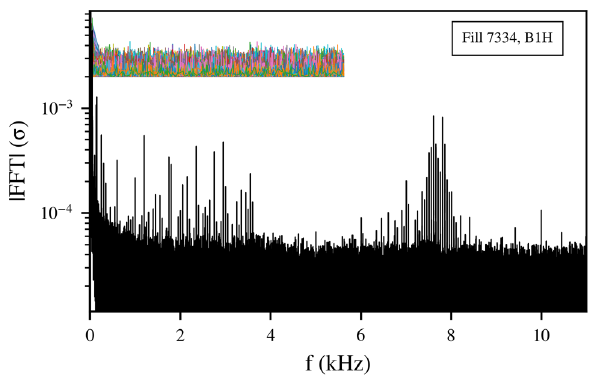
FIG. 20. The spectral envelope of several individual bunches (colored lines) and the spectrum after averaging over all the bunches in the machine